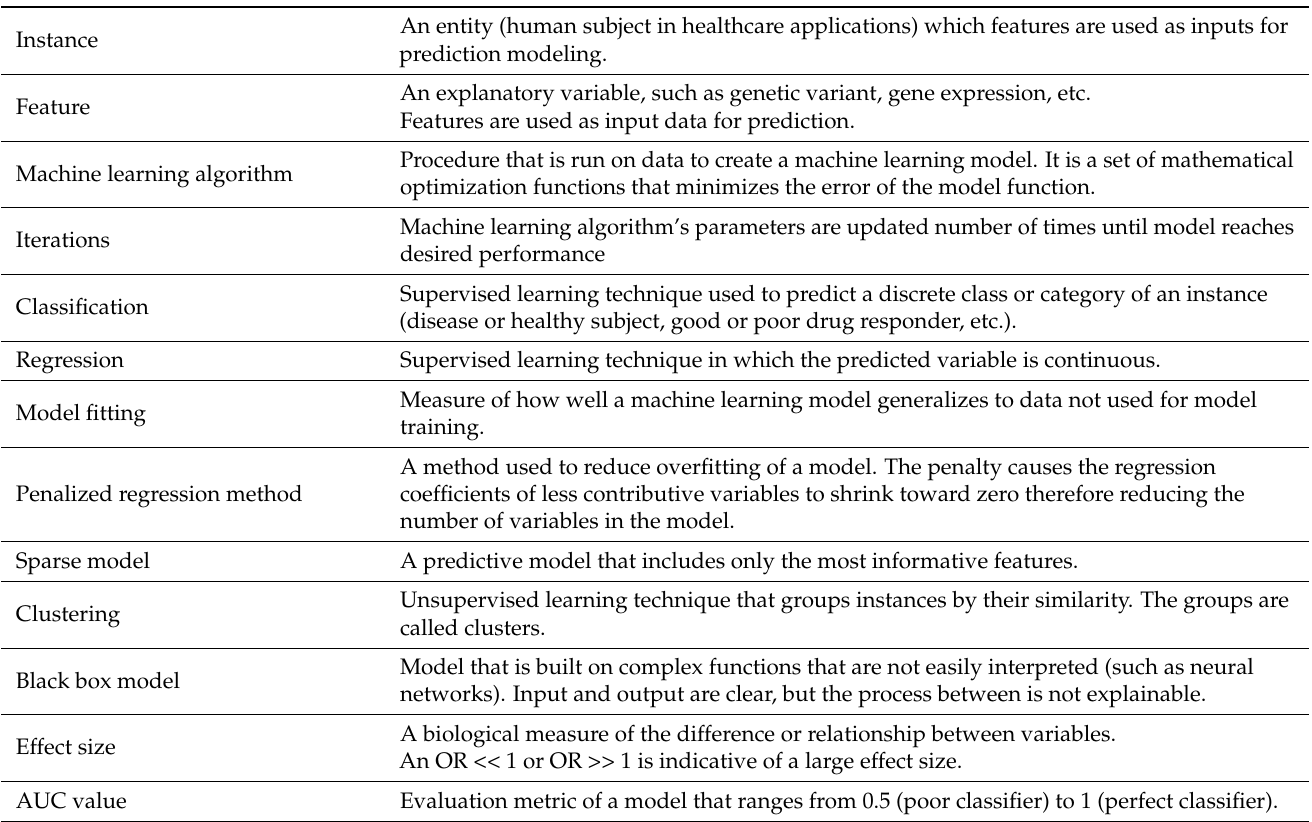
Table 1. Glossary of common terms in machine